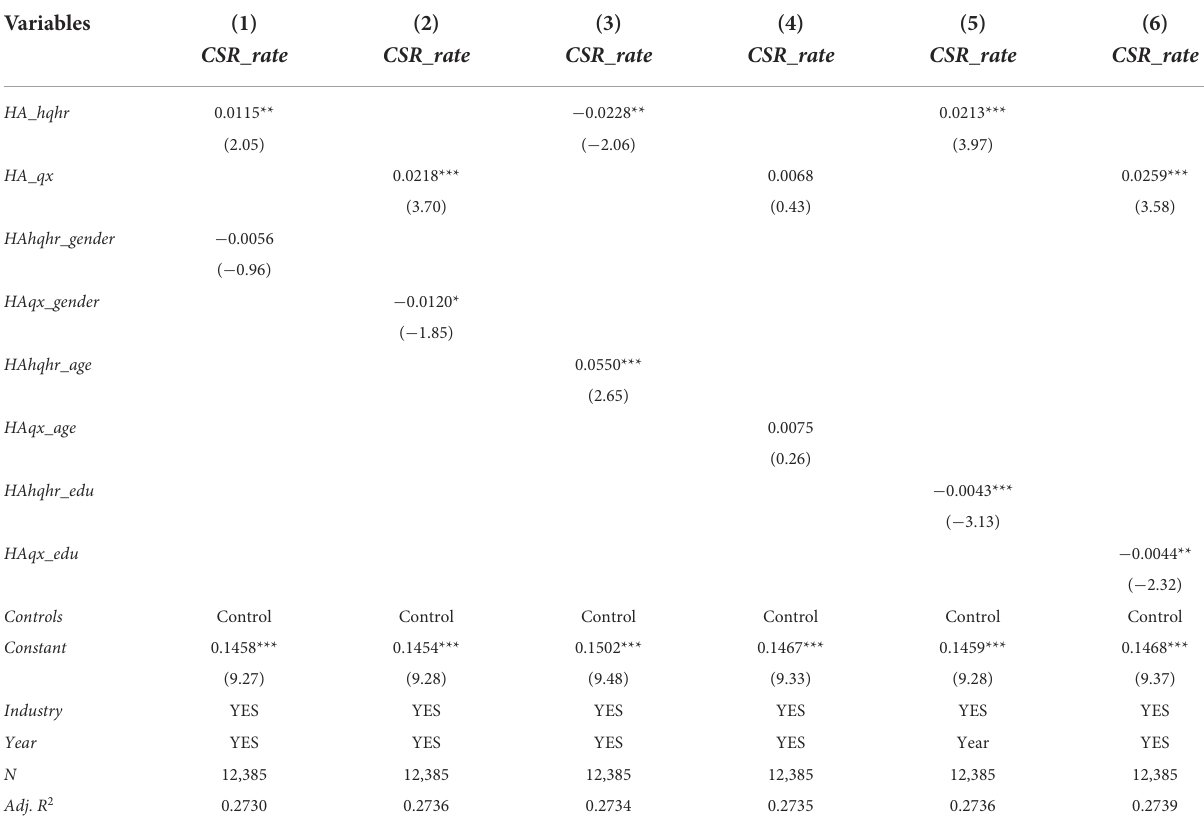
TABLE 7 The moderating effect of characteristics of the ultimate controller